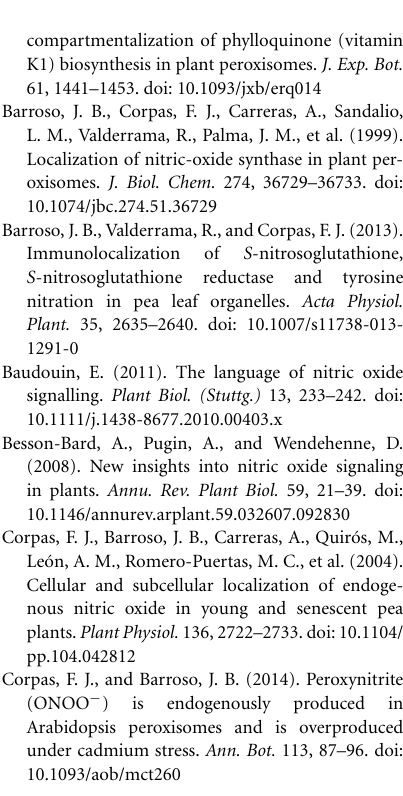
FIGURE 1 | Peroxisomal localization by confocal laser scanning microscope (CLSM) of molecules involved in NO metabolism. (A) CLSM in vivo detection of peroxisomes (green color) in primary roots of Arabidopsis seedlings expressing GFP-PTS1 (green fluorescent protein fused with peroxisomal targeting signal 1). (B) CLSM in vivo detection of NO (red color) with DAR-AM AM in the field showed in panel (A) . (C) merged images of panels (A,B) . Arrows indicate representative punctate spots corresponding to NO and peroxisome localization. (D) Model proposed for the metabolism and signaling function of nitric oxide (NO) and S -nitrosoglutathione (GSNO) in plant peroxisomes. Reproduced, with permission, from Plant Physiol. 151:2083–2094 (Copyright American Society of Plant Biologists) for panels (A–C)